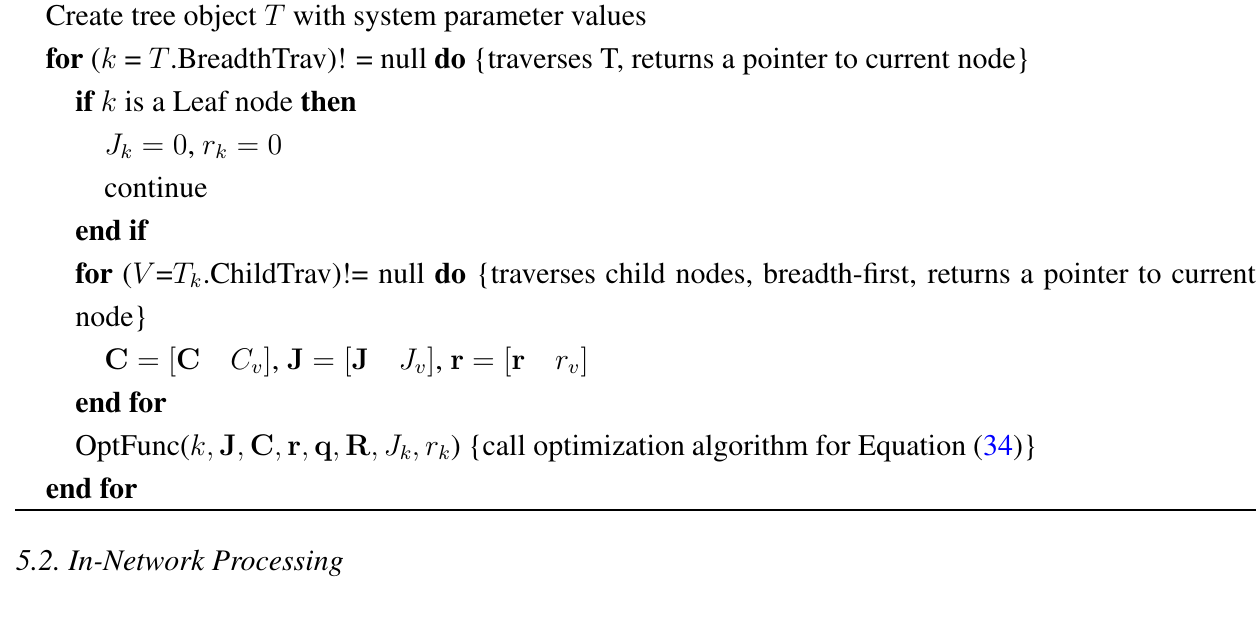
Algorithm 1 Optimization problem solution for the tree network. Create tree object T with system parameter